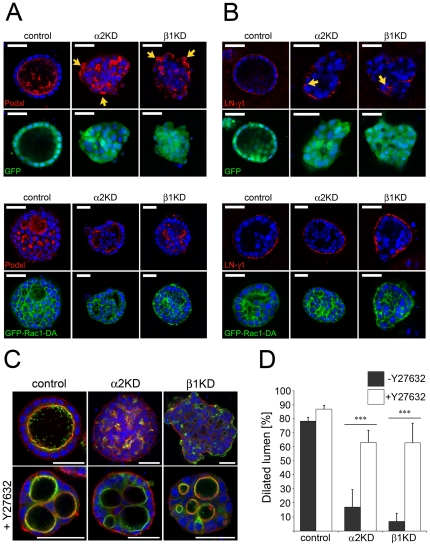
Defective basal cue in α2β1-integrin-depleted cysts is rescued by Rac1 activation or inhibition of RhoA.A) Control, Itgα2- and Itgβ1-KD MDCK cells were transduced with a GFP- (upper panels) or Rac1G12V-GFP-expressing (lower panels) retroviruses. Transduced cells were seeded into 3D collagen gels and grown for 10 days to allow formation of cysts. Cysts were fixed and stained for A) an apical membrane marker podocalyxin (Podxl) or B) for laminin-γ1 (LN-γ1, red, left panels). Grey lines in B depict the basal surface of the cysts as defined by the GFP-fluorescence. Yellow arrows depict mislocalized basal Podxl staining in A) and abnormal fragmented laminin-deposits in B) observed in the Itgα2- and Itgβ1-KD cysts. Nuclei were visualized using DAPI (blue). Size bars are 30 µm. C) Control, Itgα2- and Itgα1-KD cells were grown in 3D collagen gel for 10 days in the presence or absence of 10 µM Y27632. Cysts were fixed and stained as above. Cysts were phenotypically classified as normal when they had major dilated apical lumen(s) with smooth contour. Cysts with poorly organized lumens, multiple small lumens or with no lumen were scored as abnormal. D) The cyst phenotypes were quantified. The data shown includes averages from 3–4 independent experiments. A minimum of 200 cysts per sample was scored in each experiment. P-values ≤0.001 are signified by (***). Size bars are 30 µm.